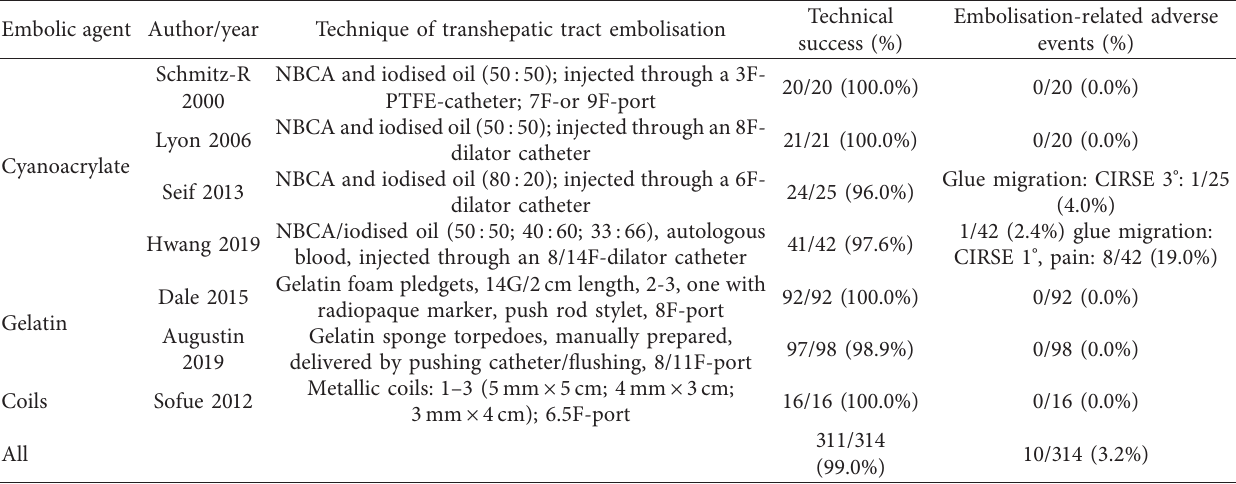
Table 2: Techniques of preventive transhepatic tract embolisation, technical success, and embolisation-related adverse events graded according to the CIRSE